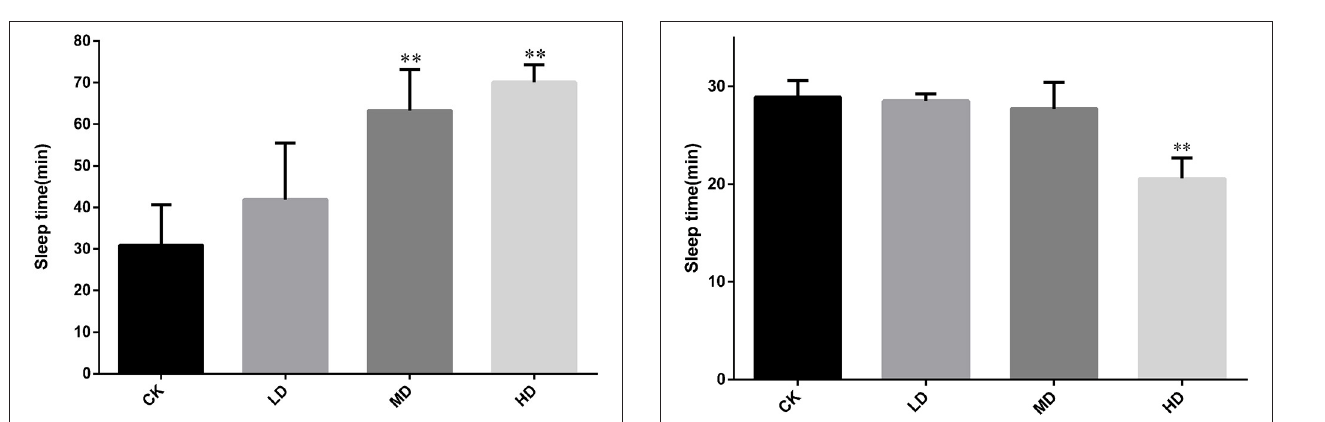
FIGURE 2 | Effect of GRAE on the length of sleep latency in mice induced by barbiturate sodium in sleep improvement experiment. Each bar represents the mean ± SD ( n = 10). * P < 0.05 vs. control group, ** P < 0.01 vs. control group.